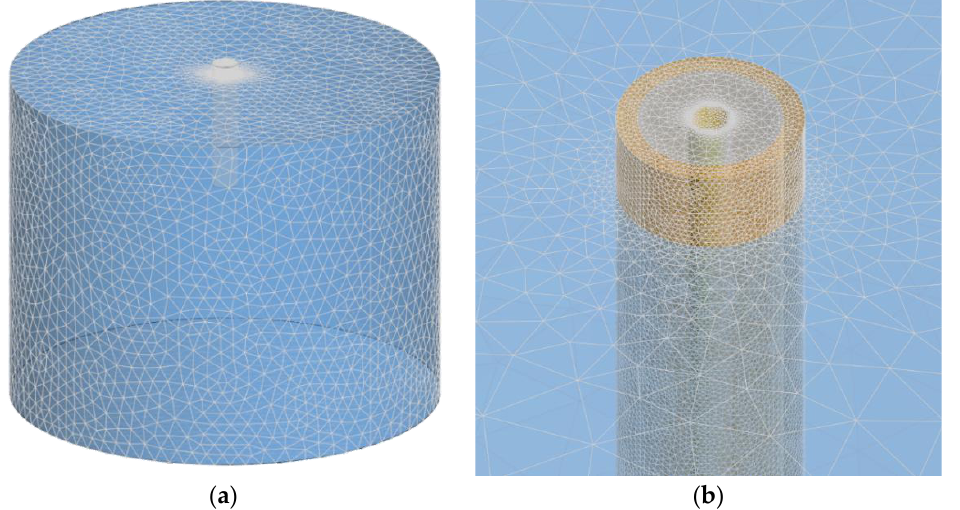
Figure 3. ( a ) FEKO model mesh (probe in MUT). ( b ) Mesh detail around the probe input port.